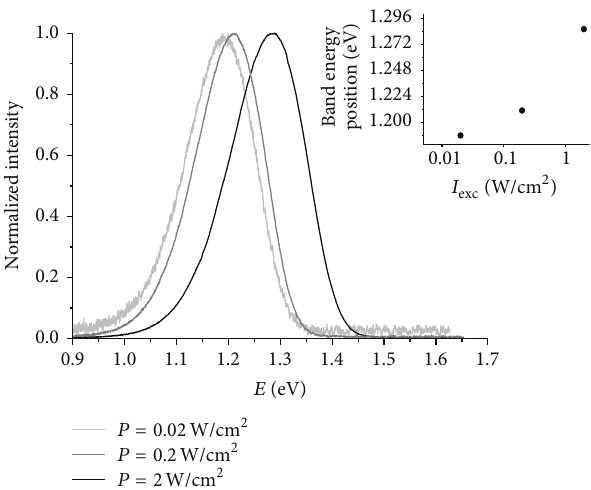
Figure 4: PL spectra at 20 K obtained for different excitation powers = 402 nm) on the as-grown CZTS samples after the etching ( 𝜆 exc procedure in aqueous HCl. The band energy shift per decade of laser power of the emission at 1.21eV is reported in the inset.